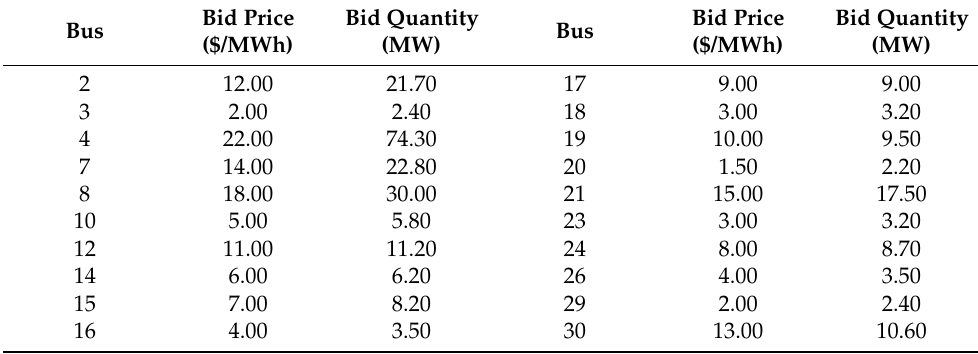
Table A1. Load and its marginal bid price of load entities of the modified IEEE-30 bus